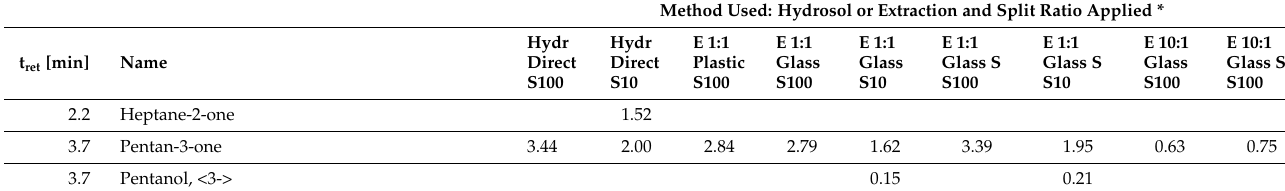
Table 1. Hydrosol compounds detected by different methods of analysis, their retention times and area % obtained. At the bottom are peak area ratios among eucalyptol, terpinen-4-ol, and